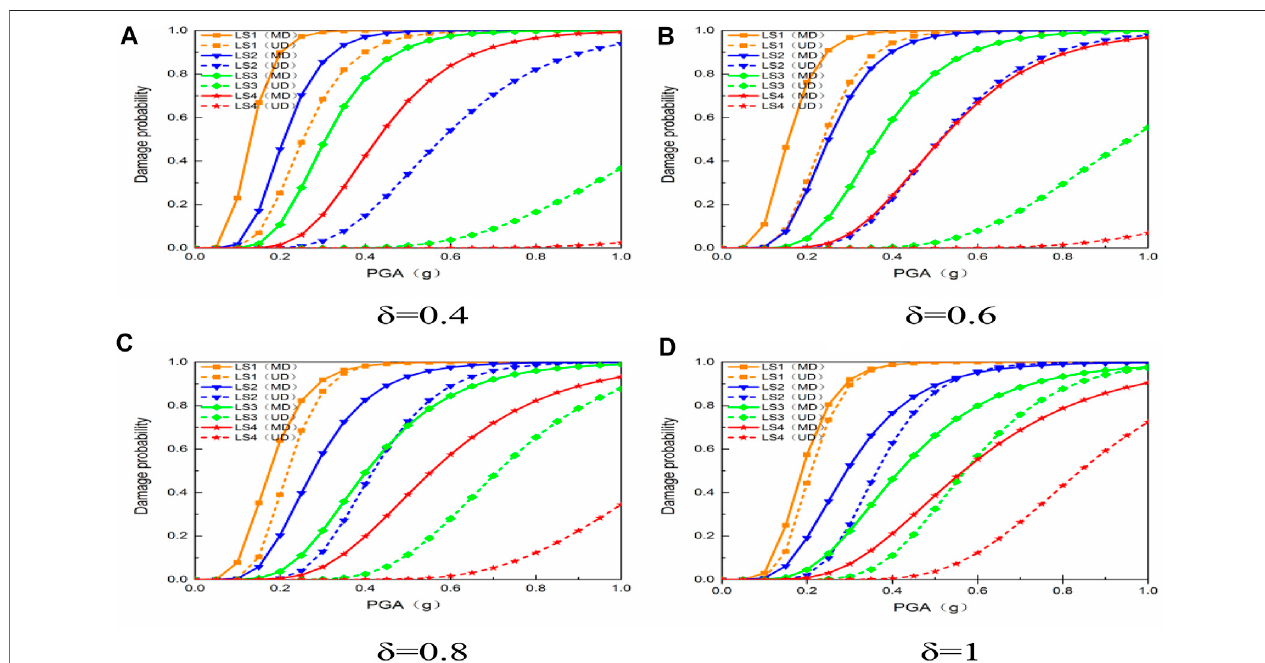
FIGURE 13 | The fragility curves of the undamaged and mainshock-damaged URM model under aftershock. (A) δ (cid:2) 0.4 (B) δ (cid:2) 0.6 (C) δ (cid:2) 0.8 (D) δ (cid:2) 1.